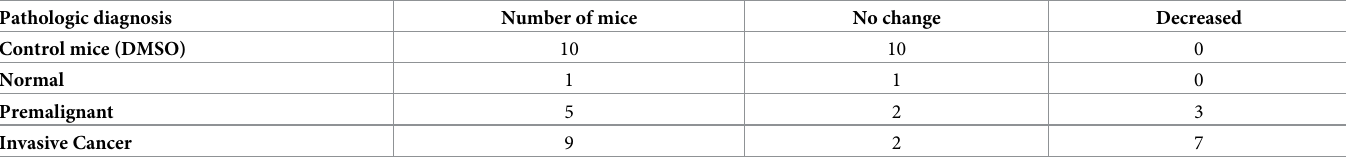
Table 1. p120ctn protein expression changes in DBPDE mice (n = 15) versus controls (DMSO) (n = 10).